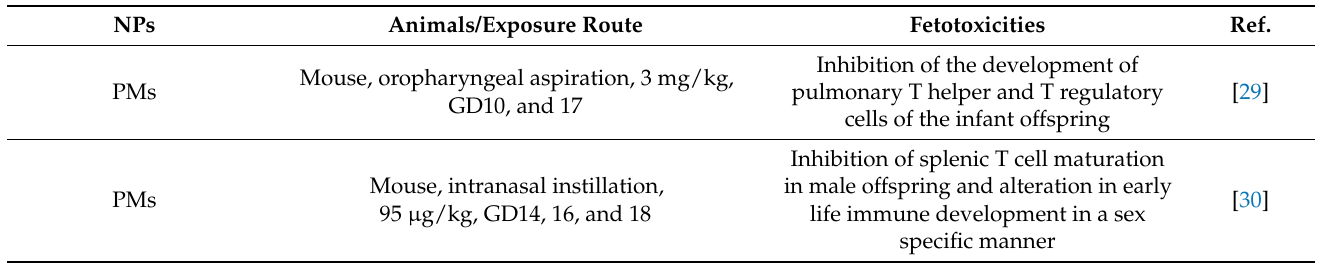
Table 4. NP-induced immunotoxicity following maternal exposure during pregnancy. NPs Animals/Exposure Route Fetotoxicities Ref. Inhibition of the development of Mouse, oropharyngeal aspiration, 3 mg/kg, PMs pulmonary T helper and T regulatory GD10, and 17 cells of the infant offspring Mouse, intranasal PMs